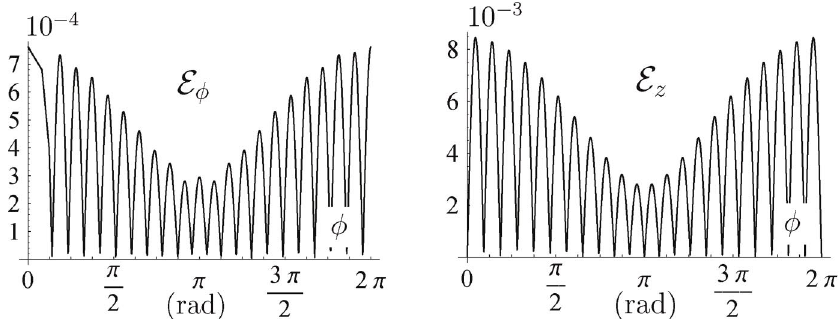
(cid:1) 0 : 76 at 1 GHz; L (cid:1) 10 but the coefficients are calculated at the order L 0 (cid:1) 16 . ( b (cid:1) 2 cm , n (cid:1) 1 ) =Y )FIG. 11. E and E for Y (cid:19) z n 0